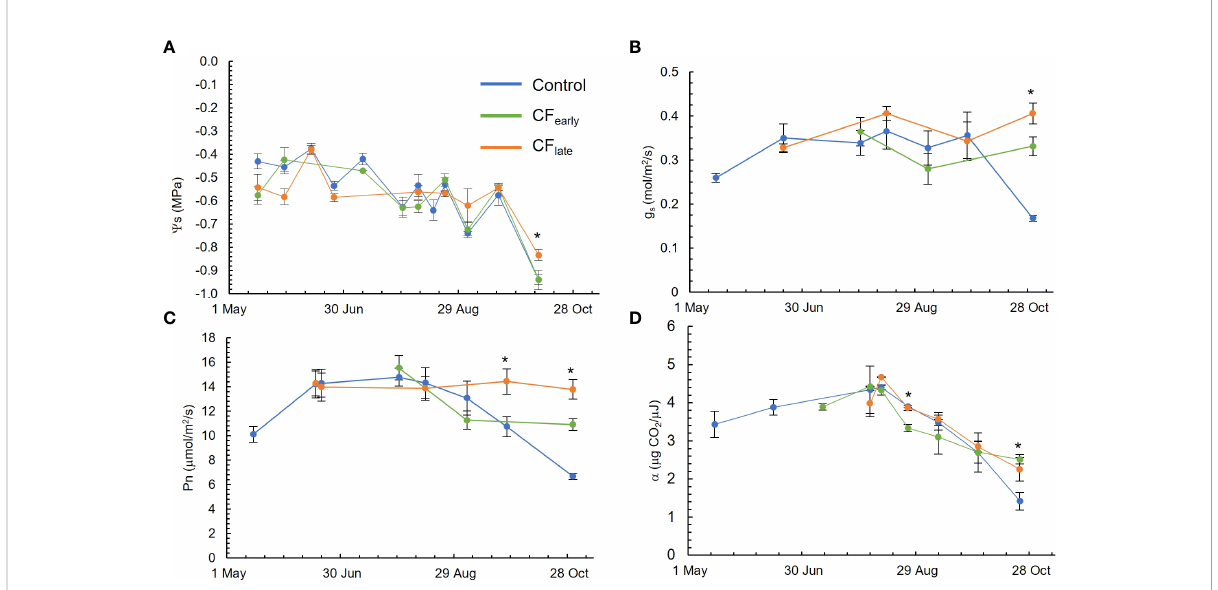
FIGURE 3 Seasonal evolution of stem water potential ( Y s ) (A) , leaf stomatal conductance at midday (g s ) (B) , sunlit leaf net photosynthesis at midday (Pn) (C) and quantum yield ( a ) (D) in the 2019 season. Blue, green, and orange lines correspond to the Control, CF early and CF late treatments, respectively. Bars indicate standard deviation of eight measurements excepting for quantum yield in which three measurements were carried out. * indicates statistical differences using ANOVA (P < 0.05).